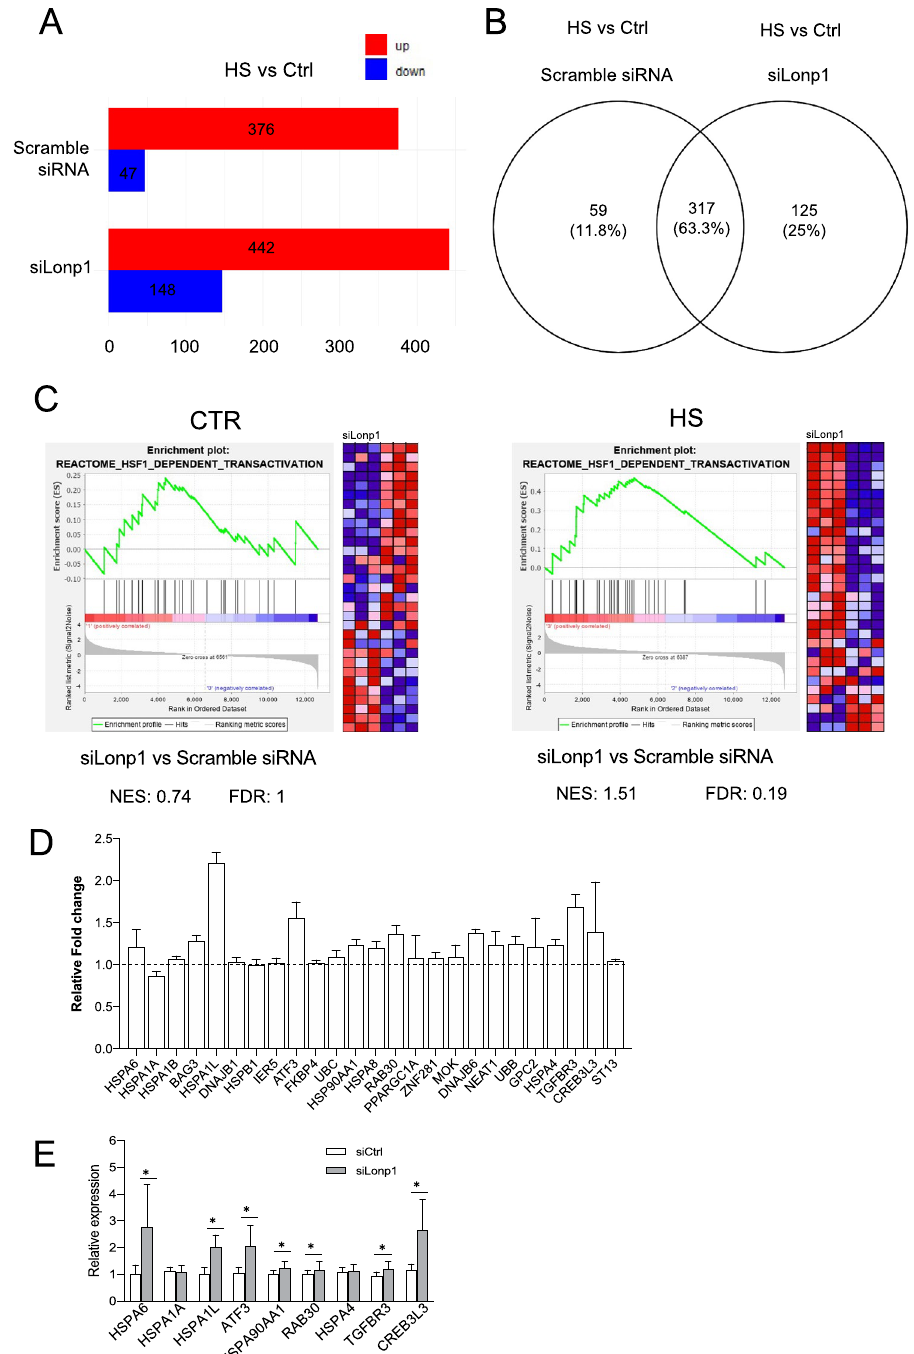
Figure 4. Silencing of Lonp1 enhances HSF1-mediated response to HS. ( A ) Number of genes significantly up- or down- regulated in SW620 cells transfected with small-interfering RNAs against Lonp1 (siLonp1) or with a scramble siRNA, kept at 37 °C (Ctrl) or at 42° for 1 h (HS). FDR q value ≤ 0.05 was used to identify differentially expressed genes, with fold change (FC) > 2 for up-regulated and FC < 2 for down-regulated genes. ( B ) Venn diagram showing the overlap between genes upregulated in HS, in cells where Lonp1 was silenced (siLonp1) or not (Scramble) in SW620 cells. ( C ) Left panel: Gene set enrichment analysis (GSEA) plots for the “Reactome—HSF1 dependent transactivation” signature in SW620 cells transfected with small-interfering RNA against Lonp1 (siLonp1) in comparison with a scramble siRNA, kept at 37 °C. Right panel: Gene set enrichment analysis (GSEA) plots for the “Reactome—HSF1 dependent transactivation” signature in SW620 cells transfected with small-interfering RNA against Lonp1 (siLonp1) in comparison with a scramble siRNA, kept at 42° for 1 h. The Normalized enrichment score (NES) and FDR values for both analyses are reported. ( D ) Ratio between fold change observed after HS in cells treated with siLonp1, and fold change observed after HS in cells treated with a scramble siRNA. Twenty-five HSF1 target genes are shown; data are calculated from RNAseq data set, and expressed as mean ± SD. ( E ) Relative expression of nine selected HSF-1 target genes in cells in cells treated with siLonp1 after HS. Data have been normalized to the expression observed after HS in cells treated with a scramble siRNA, set arbitrarily to one. Data are the mean ± SD of two independent experiments, each in triplicate. * p <